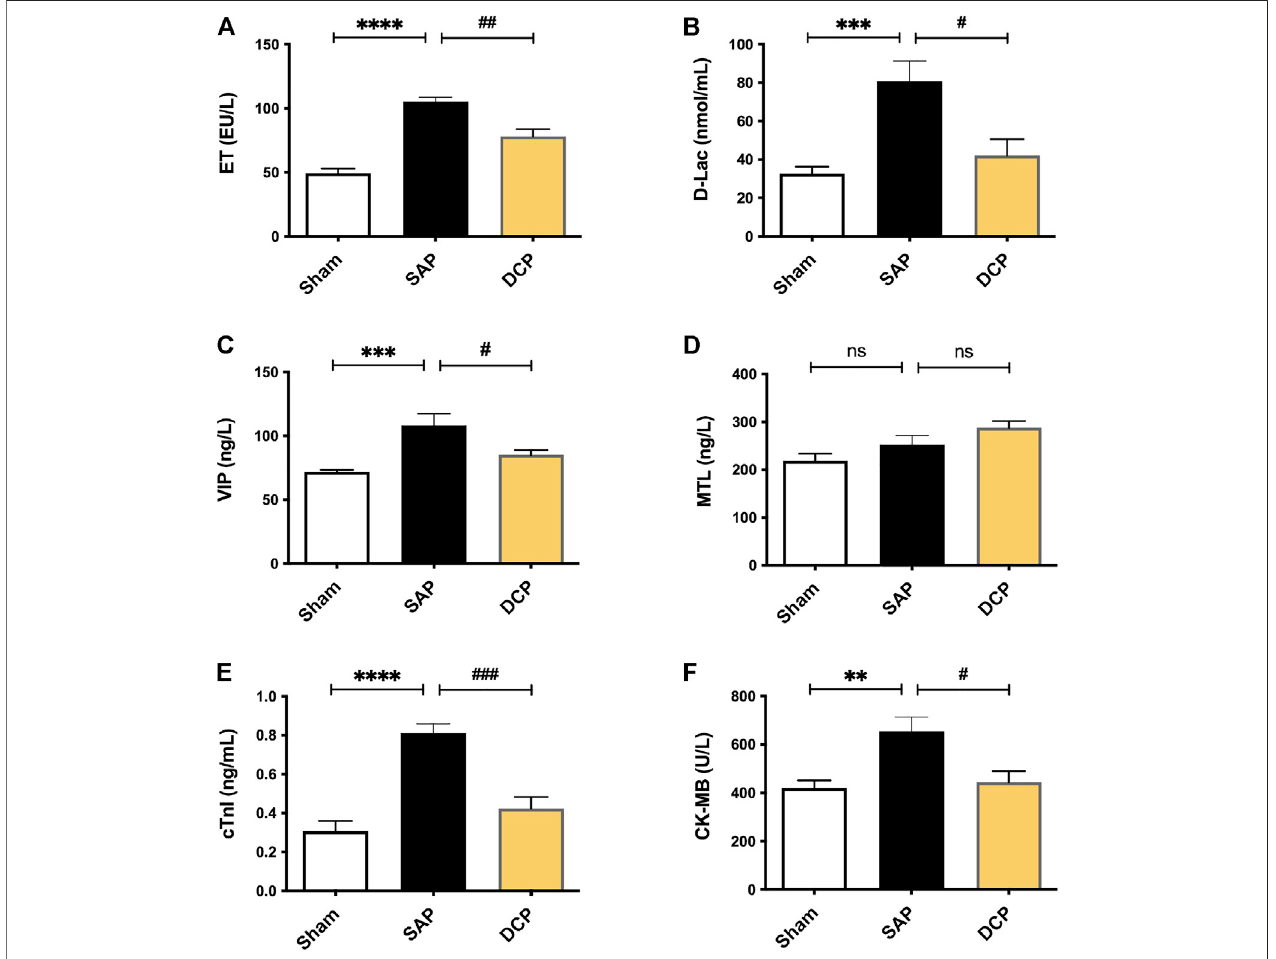
FIGURE 2 | DCP reduced the markers of gastrointestinal and cardiac injuries in serum. (A – F) : Serum levels of ET, D-Lac, VIP, MTL, cTnI and CK-MB in rats from Sham, SAP and DCP group. The results are presented asthe mean ± SEM. ** p < 0.01, *** p < 0.005, **** p < 0.0001 vs. sham group, # p < 0.05, ## p < 0.01, ### p < 0.005 vs. SAP group; ns, p > 0.05. sham: sham operation group; SAP: Sever acute pancreatitis group; DCP: Dao-Chi powder treatment